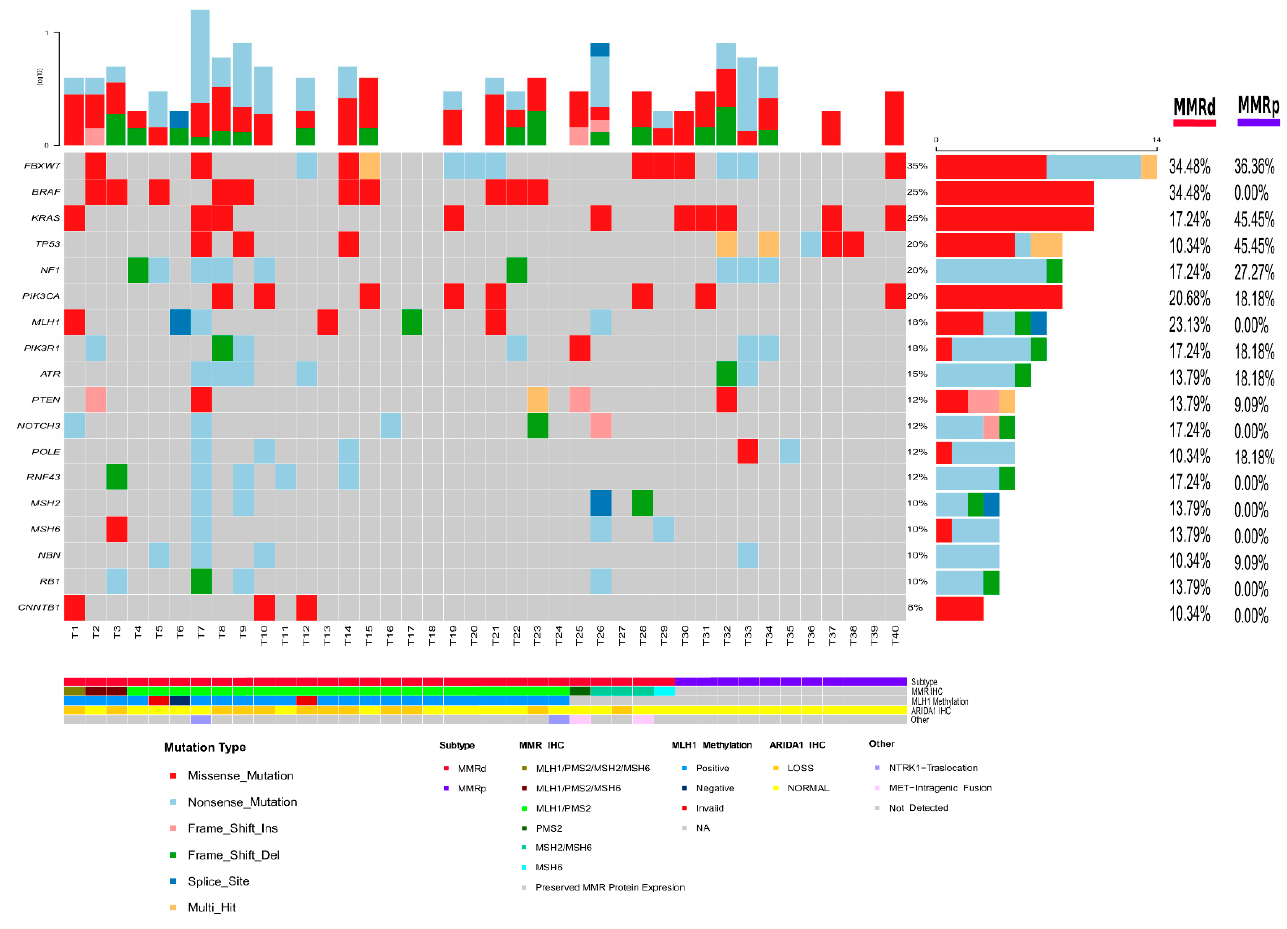
Figure 1. Summary of the molecular characteristics observed in high-grade colorectal carcinomas. Only one MMRp tumor carried a pathogenic mutation (P286C) involving the exonu- clease domain of POLE